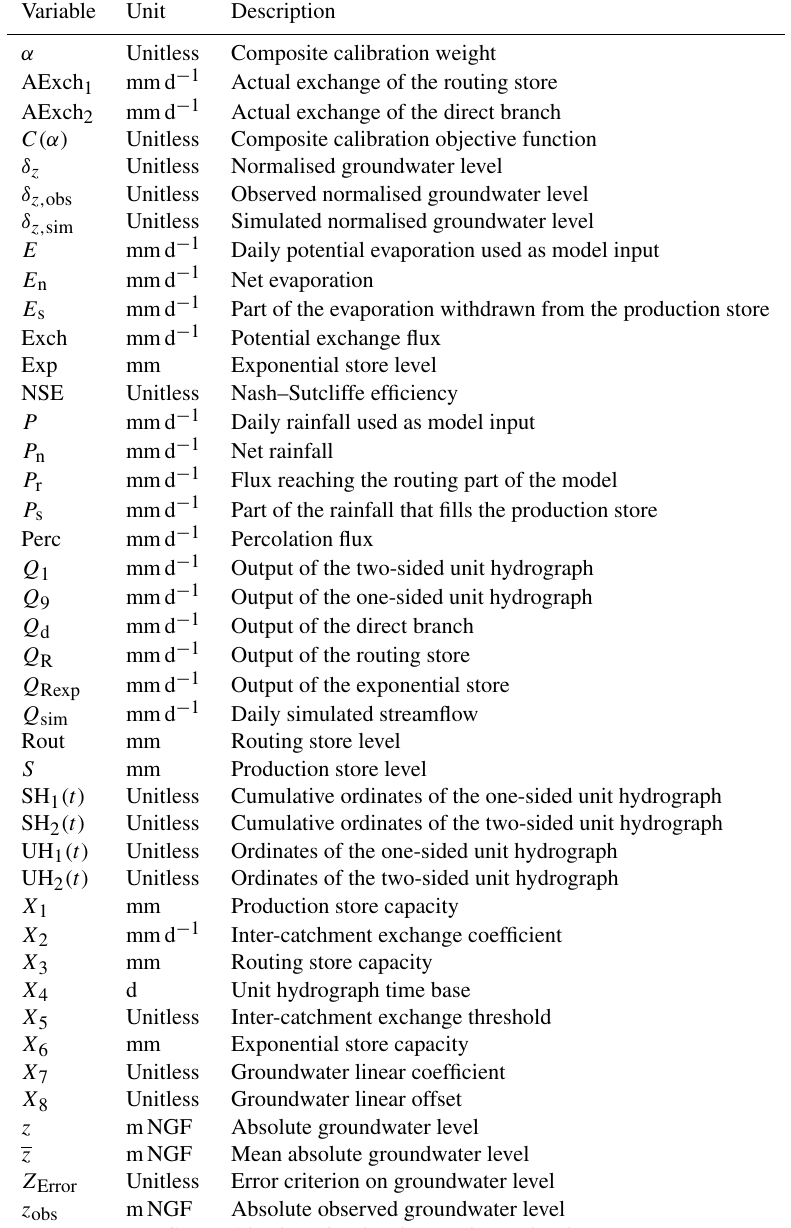
Table C1. Table of variables used in the